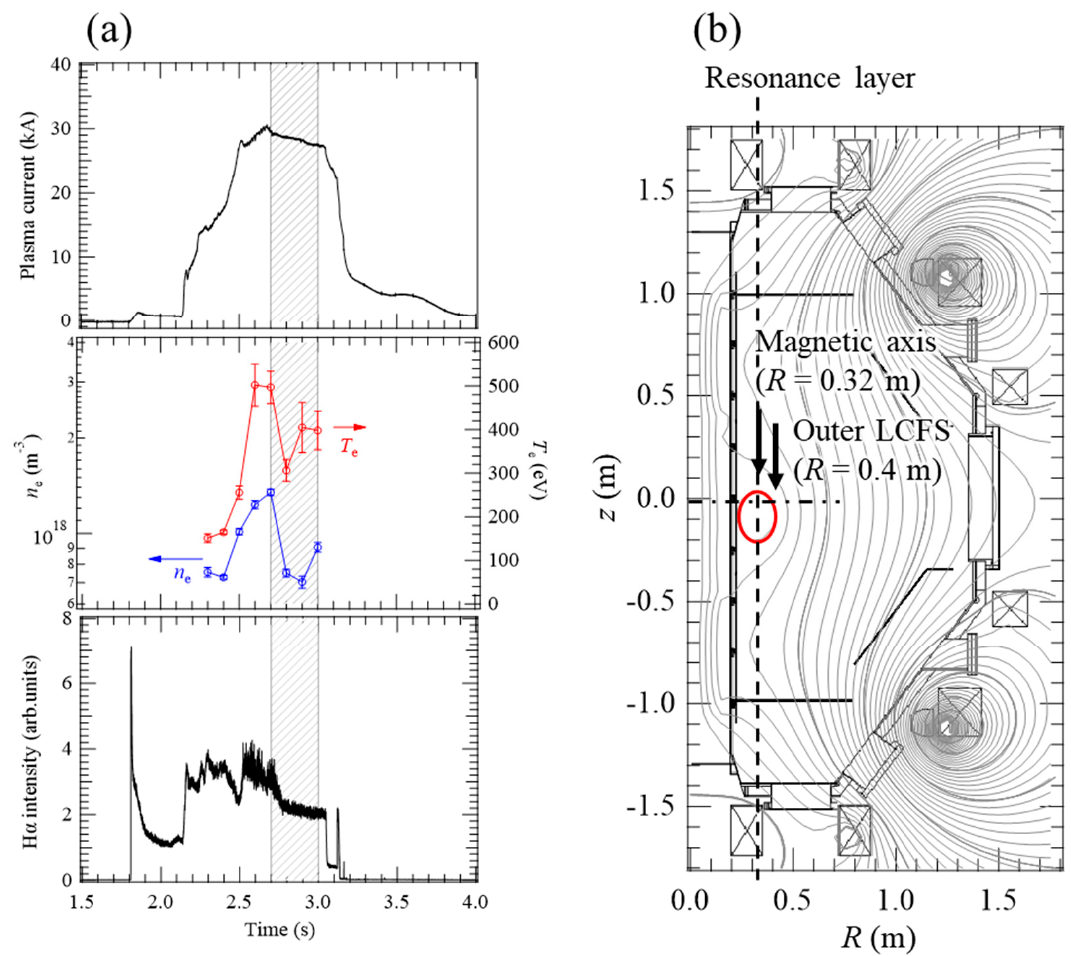
Figure 1. ( a ) Temporal evolutions of the plasma current, electron temperature, and density at the core ( R = 0.34 m, z = 0 m) (#41176), and chord-integrated H α intensity (#41178). ( b ) Equilibrium magnetic flux surfaces in the time period t = 2.7–3.0 s denoted by the shaded area in ( a ). The last closed flux surface (LCFS) is shown by the red line.